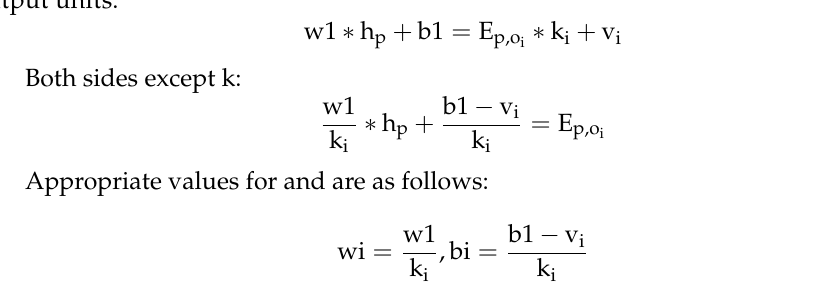
of the hidden unit coincide with the error fluctuations of the output